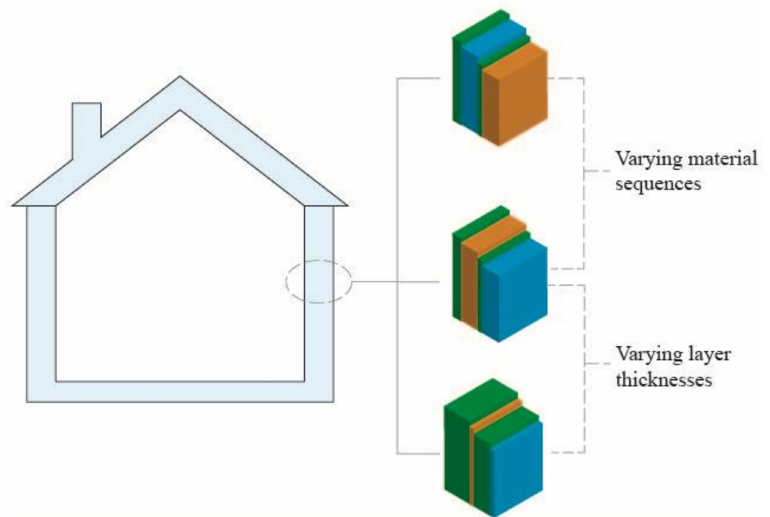
Figure 1. Schematic of the position of PCM in a wall (Note that the colors refer to different materials, e.g., concrete as blue, insulation layer as green, PCMs as